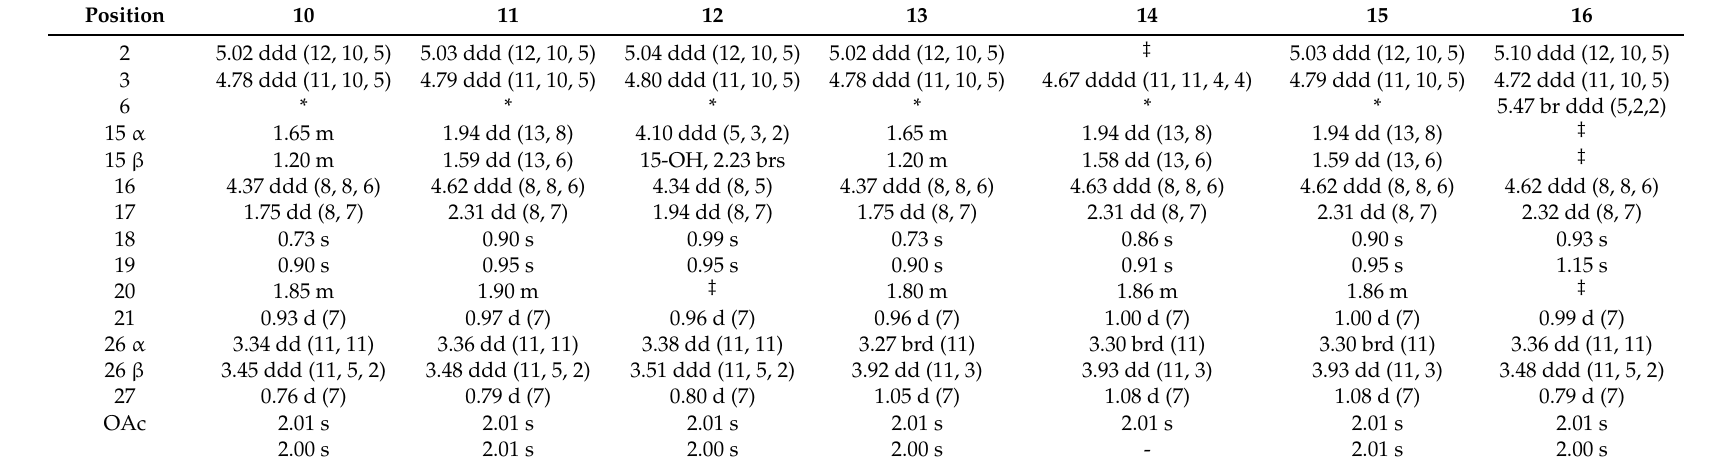
Table 4. Selected 1 H-NMR Spectral Data of Compounds 10 – 16 (400 MHz, CDCl 3 , δ -values in ppm, J in